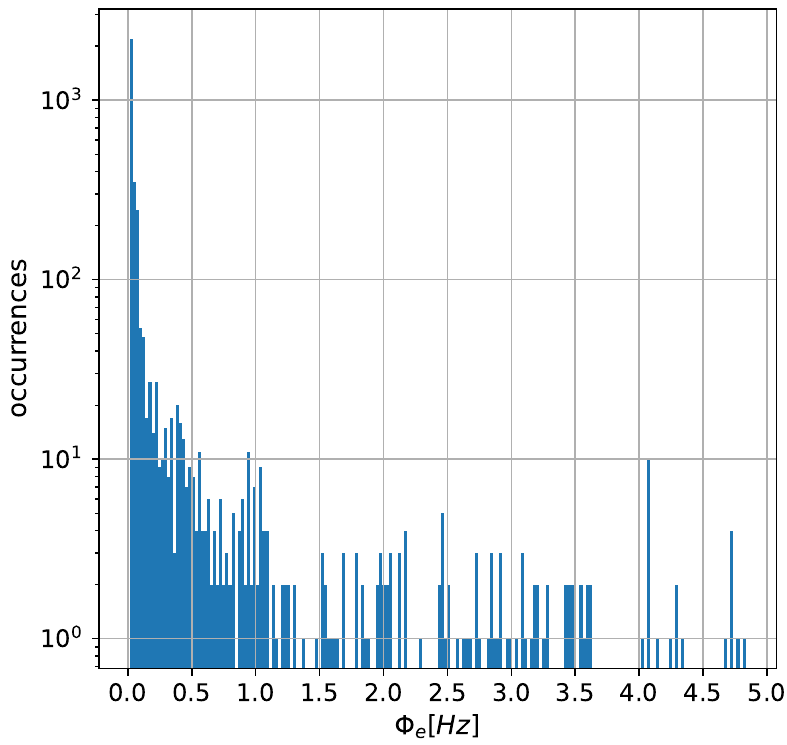
Figure 6. Histogram of sampling frequencies in the network.